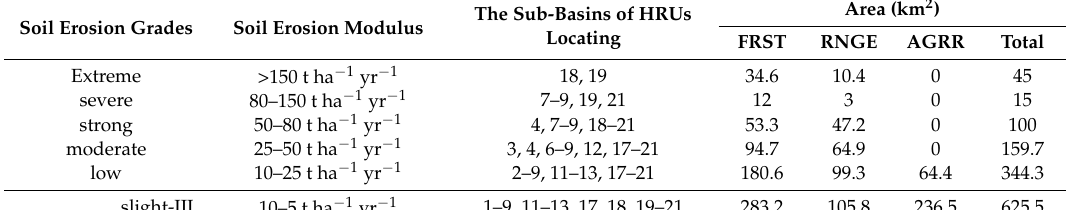
Table 4. The distribution of different erosion grades of HRUs in sub-basins under Scenario 0. Soil Erosion Grades